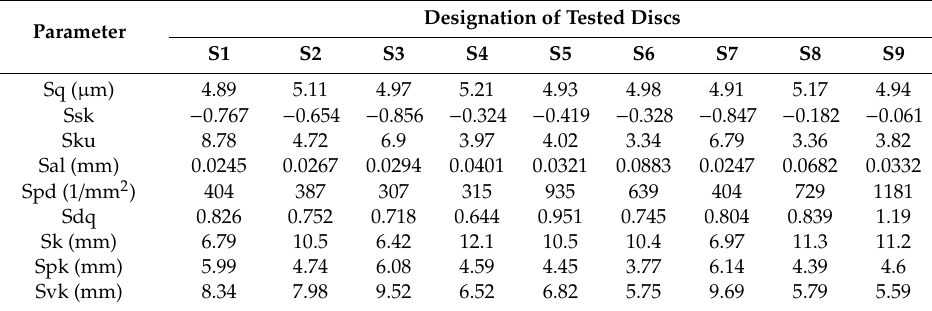
Table 1. Surface topography parameters of disc